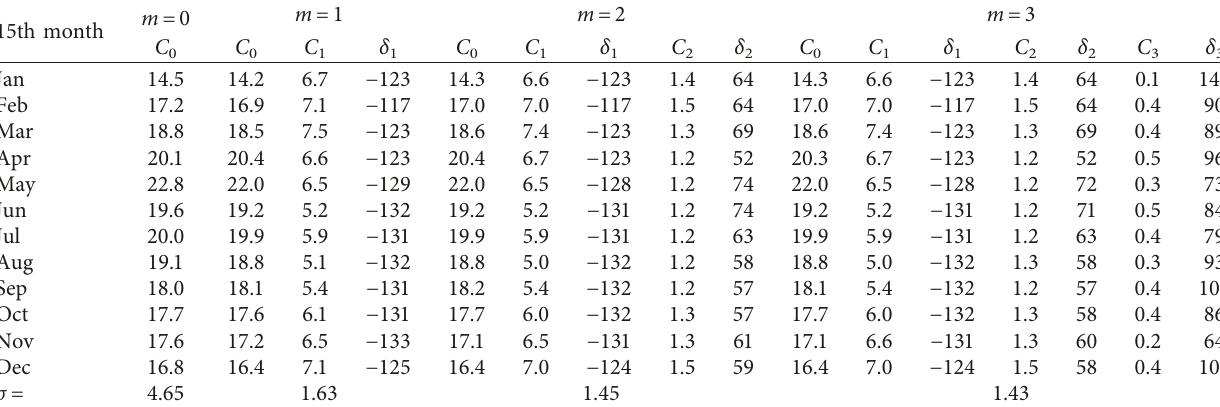
Table 1: Fourier parameters for the temperature T